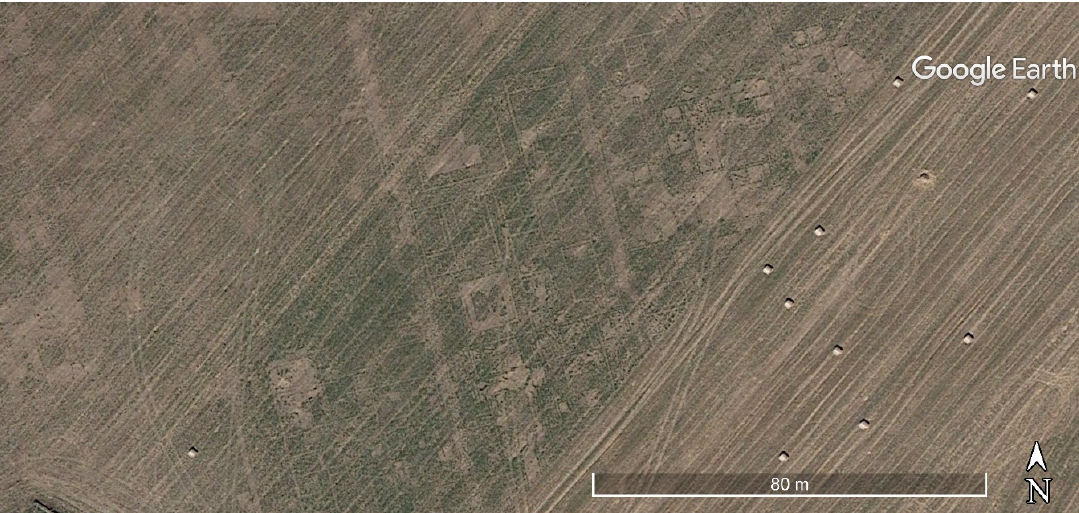
Figure 1. An example of cropmarks in Google Earth in the case of the ancient Roman city of Ferentium. The image acquisition date is reported to be 7 August 2013. Courtesy of Google Earth Pro.